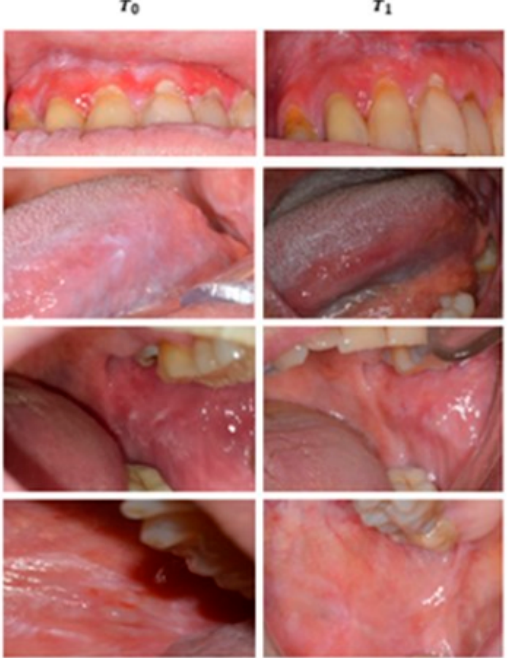
Figure 2. Intra-oral photos of some of the subjects who joined the clinical trial at T0 and T1. The action of the drug on the lesions can be seen after 12 weeks of treatment (Clobetasol group).